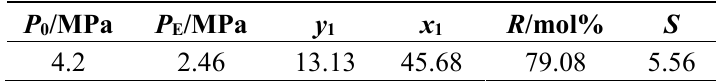
Table 5. Separation results for C 2 H 4 /CH 4 (30.08/69.92 mol%) mixture in diesel-water emulsion. Initial gas-liquid ratio Φ , initial pressure, temperature, and water cut were specified to 80, 4.2 MPa, 274.15 K, and 20 vol%, respectively.